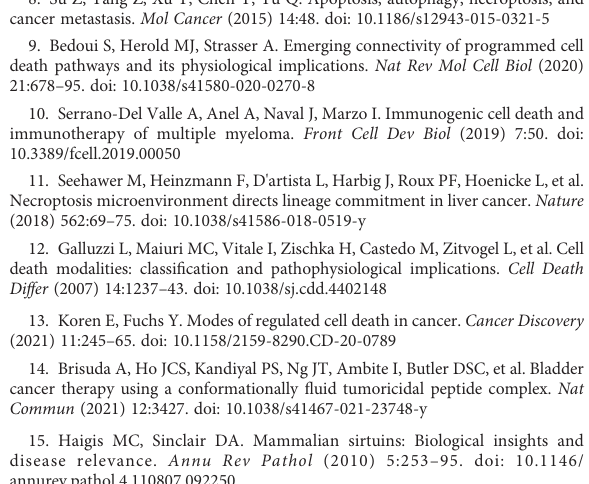
SUPPLEMENTARY FIGURE 1 Summary of immune cell scores of each type of immune cell between high- and low-PPRPS groups based on 7 algorithms. *p < 0.05, **p < 0.01, ***p < 0.001. SUPPLEMENTARY FIGURE 2 Immune microenvironment, immune-related pathways, tumor microenvironment (TME) and checkpoint genes in the low- and high- PPRPS groups of the IMvigor210 cohort. (A) Scores of 13 immune-related pathways in the low- and high-PPRPS groups. (B) Twenty-nine functional gene expression signatures describing the TME in the low- and high- PPRPS groups. (C) Scores of immune checkpoint genes in the low- and high-PPRPS groups. *p < 0.05, **p < 0.01, ***p < 0.001. SUPPLEMENTARY FIGURE 3 Validation of the Pan-PCDs ’ effect on the prognostic value of PPRPS in kidney cancer and prostate cancer. Kaplan – Meier (K-M) curve of the high- and low-PPRPS groups in kidney renal clear cell carcinoma (KIRC) (A) , kidney renal papillary cell carcinoma (KIRP) (B) , and prostate adenocarcinoma (PRAD) (C) demonstrating a great prognosis in patients. (D) the PPRPS did not show a good prognostic value to kidney chromophobe